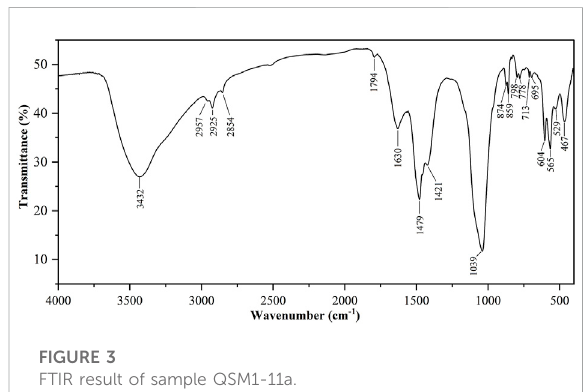
FIGURE 3 FTIR result of sample QSM1-11a.